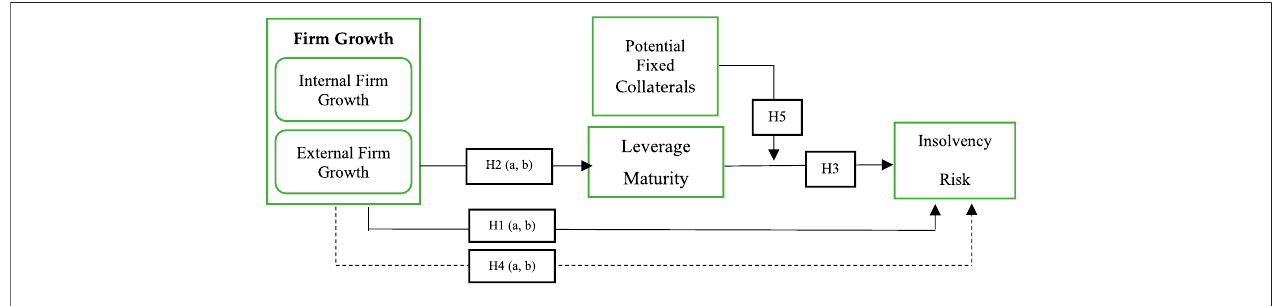
FIGURE 1 | Conceptual framework of the current